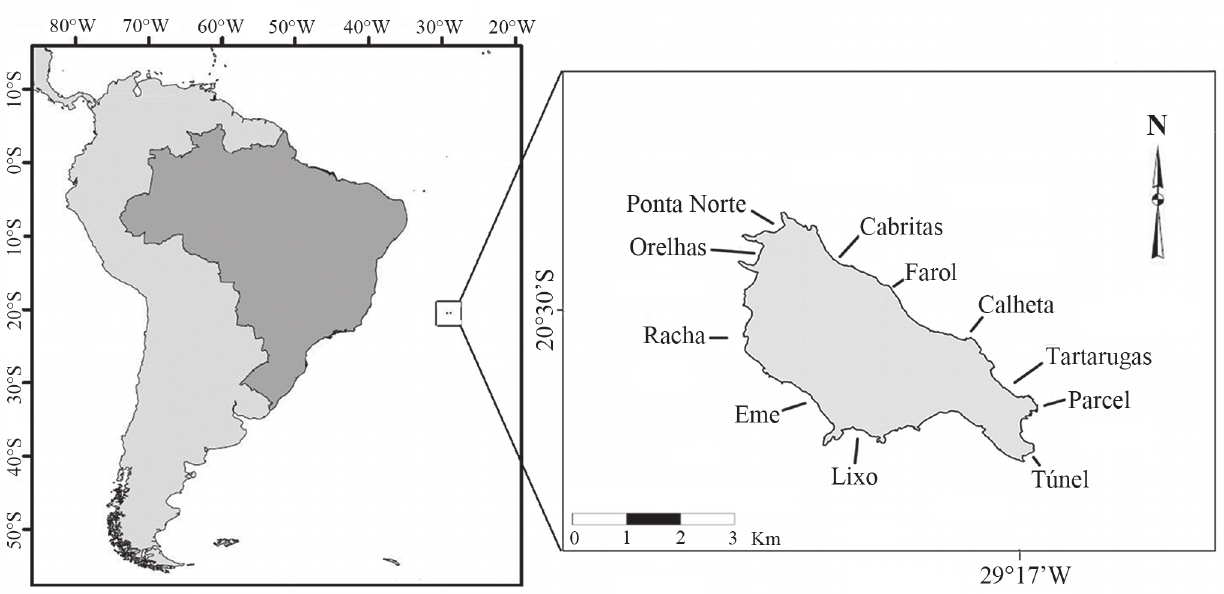
Fig. 1. Map of Trindade Island, off the Brazilian Central Coast, indicating the sampled